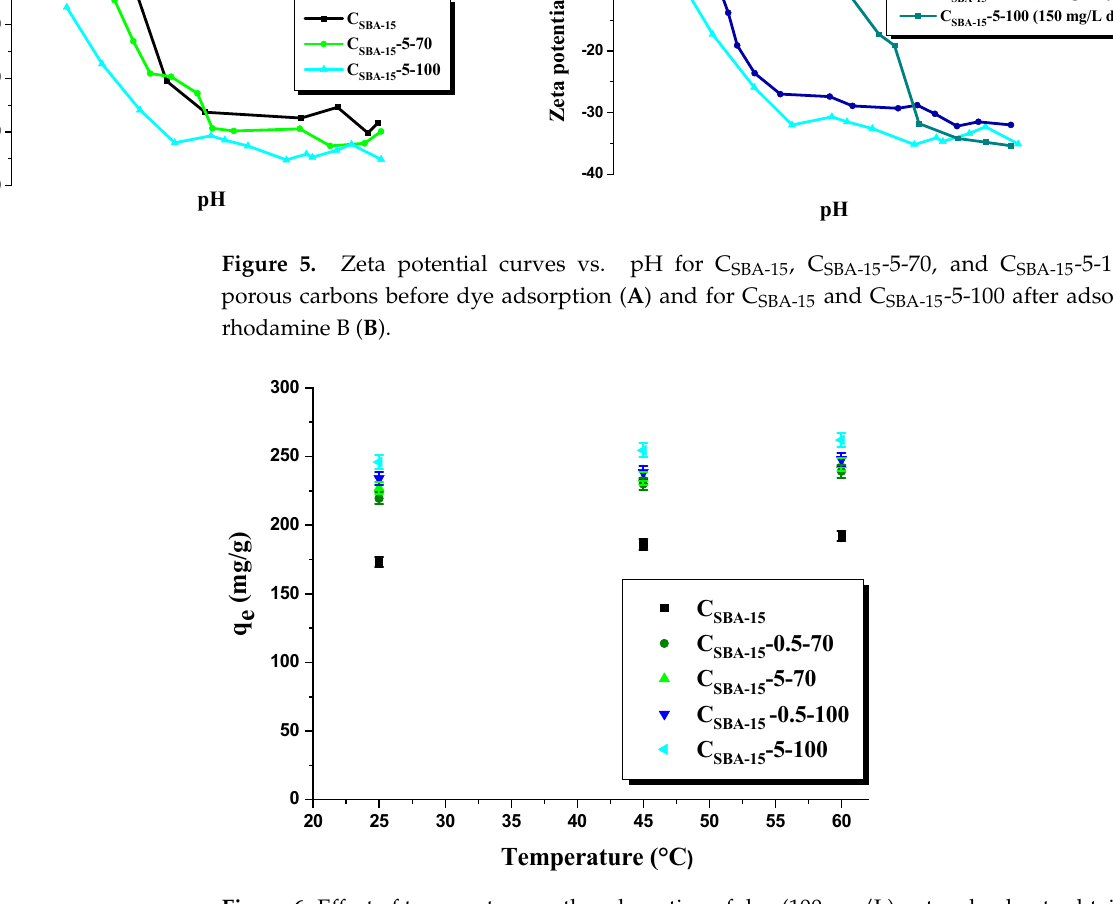
Figure 6. Effect of temperature on the adsorption of dye (100 mg/L) onto adsorbents obtained.